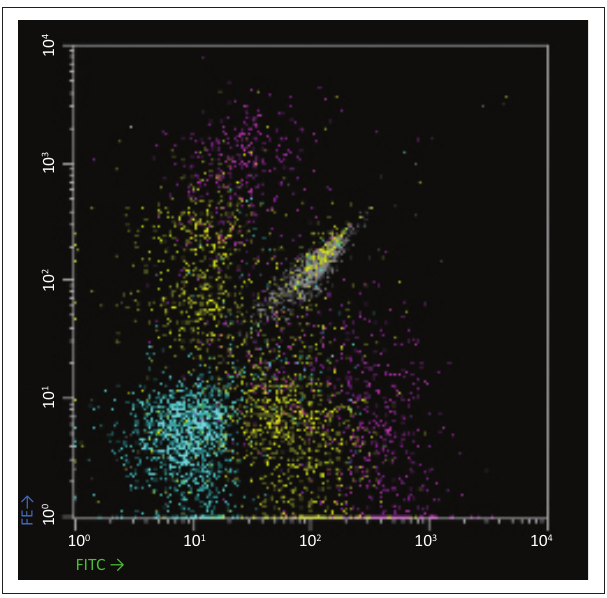
FIGURE 3: Immunophenotypic analysis of the peripheral blood performed on a dual laser FACSCalibur equipped with CellQuest Pro and PAINT-A-Gate Pro software. Kappa is the monoclonal antibody on FITC, and lambda is the monoclonal antibody on PE. There is a population of polyclonal plasma cells (yellow population), polyclonal B-cells (violet population) and T-cells (cyan).